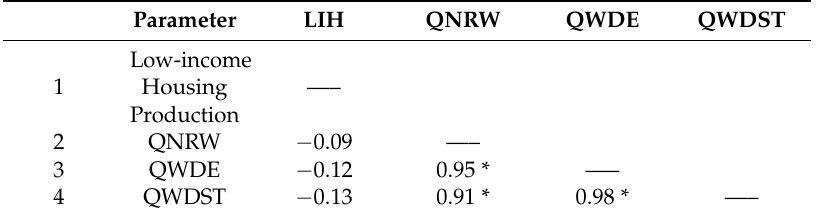
Table A6. Correlation between low-income housing production and the quality